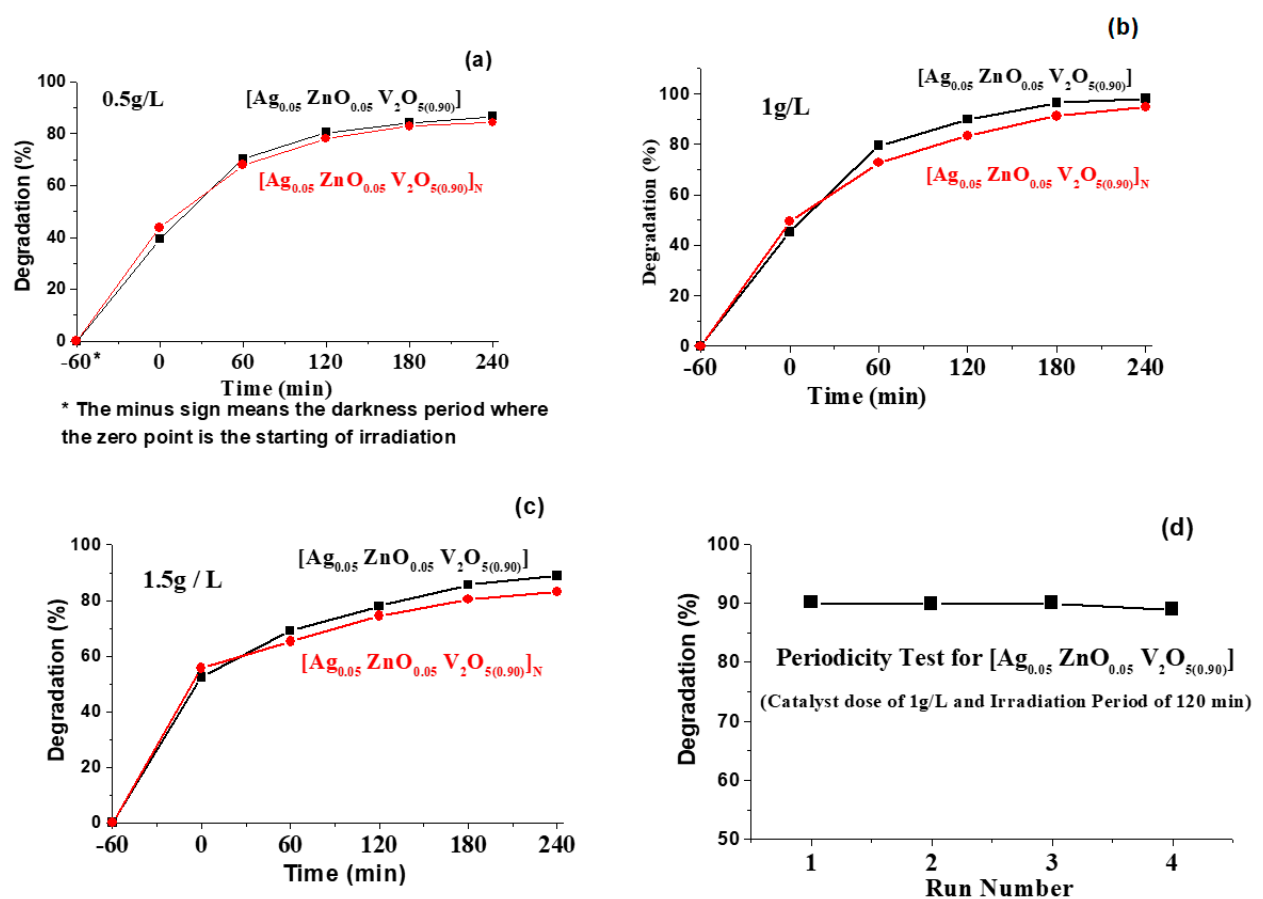
Figure 9. The catalytic performance of the as-prepared photocatalysts at catalyst dose of ( a ) 0.5 g L − 1 , ( b ) 1.0 g L − 1 , ( c ) 1.5 g L − 1 , and ( d ) the reusability test for [Ag 0.05 ZnO 0.05 V 2 O 5(0.90) ].